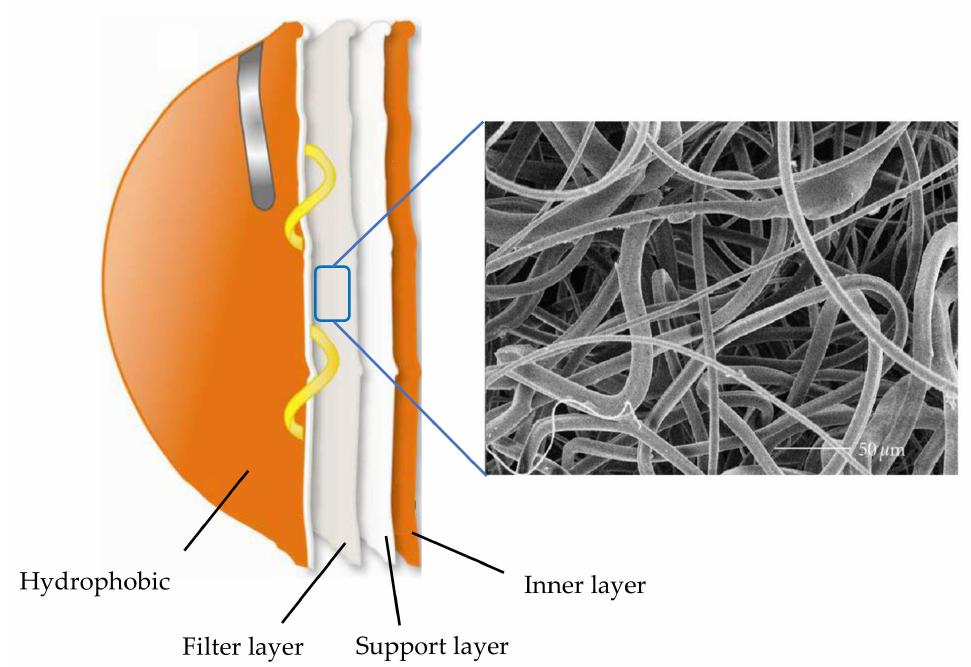
Figure 4. Structure of N95 respirator (adapted with permission from Reference [49]).